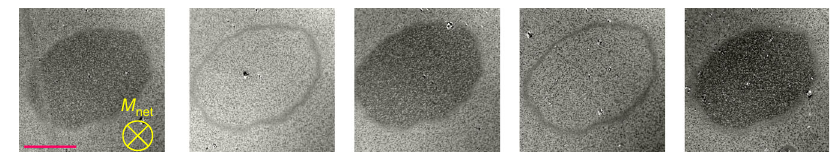
Fig. 3 Toggling of magnetization in a high-coercivity Mn 2 Ru 0.9 Ga fi lm. Repeated toggling of the micron-scale domain pattern of a virgin-state sample is observed with repeated pulses. There was a net imbalance of domains pointing in and out of the plane. The scale bar represents a length of 50 µ m.